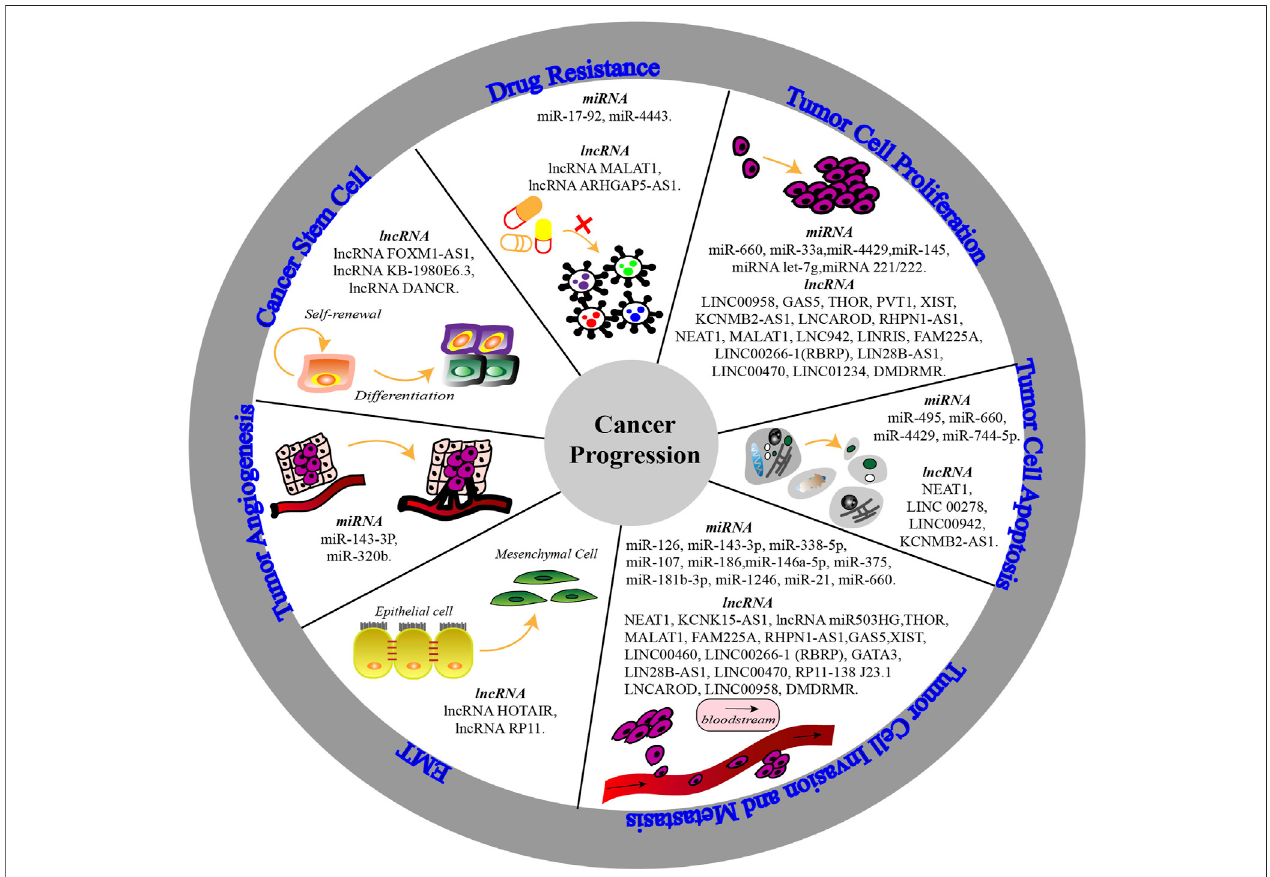
FIGURE 3 | The mechanisms of non-coding RNA (miRNA & lncRNA) m6A modi fi cation involved in cancer progression. The biological functions of non-coding RNAs are altered by abnormal m6A modi fi cation and the interaction with m6A regulators. Thereby, non-coding RNAs participate in tumor cell proliferation, apoptosis, invasion and metastasis, epithelial-mesenchymal transition (EMT), tumor angiogenesis, cancer stemness and drug resistance to affect cell characteristics and cancer progression.